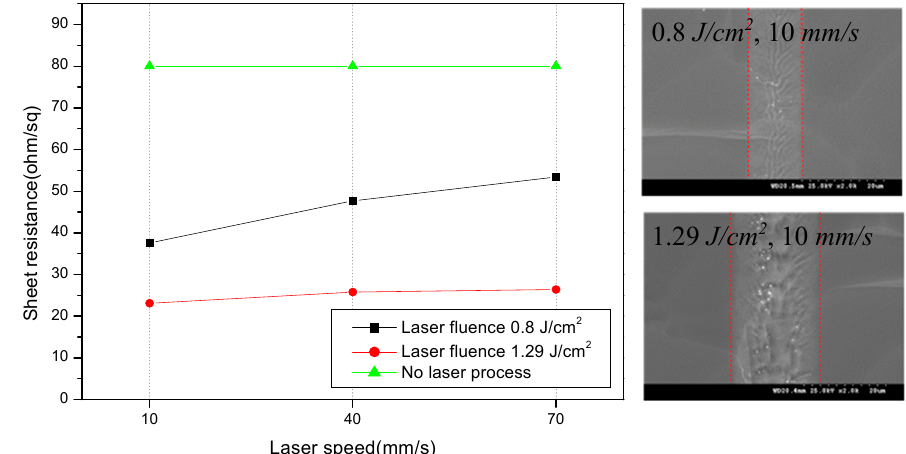
Figure 6. Sheet resistance versus laser speed after fixing the laser fluence and surface image of the Si wafer at different laser speeds.